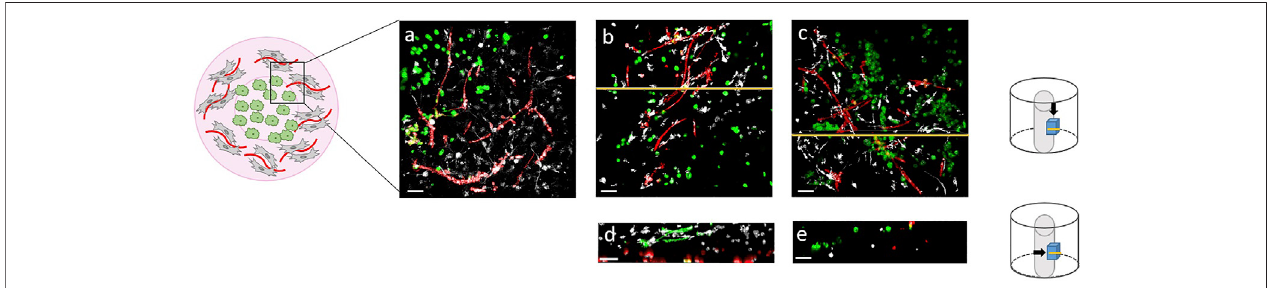
FIGURE 2 | Tri-cultures of HUVECs (red), ASCs (grey) and A549 lung cancer cells (green) in fi brin gels. Top view (A – C) and cross-sections (D – E) of the gels after 21 days of culture (TPLSM images). Scale bar: 50